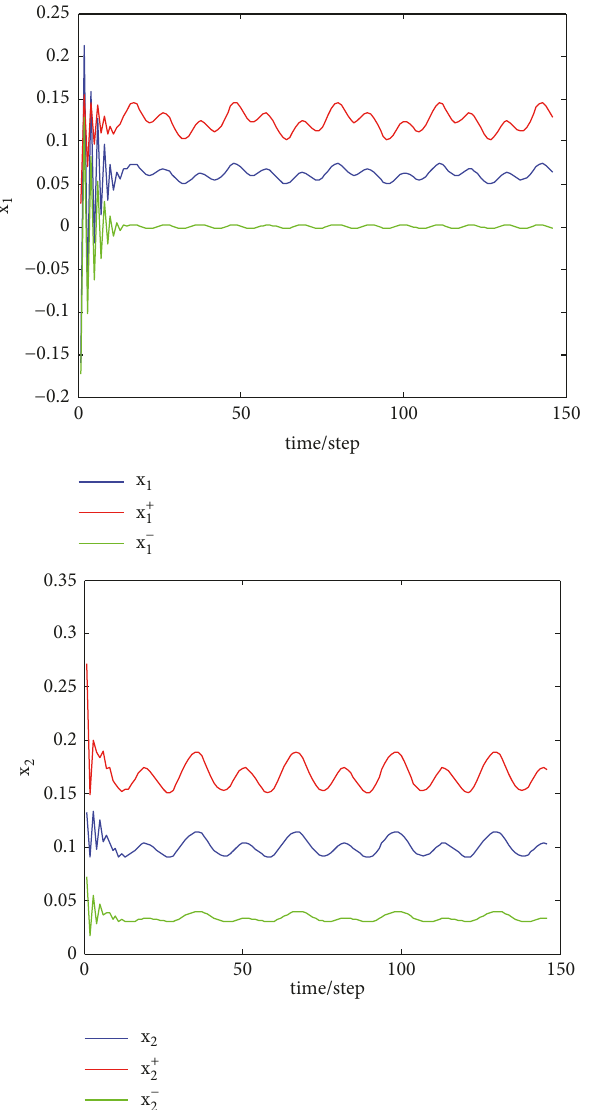
Figure 1: Interval state estimation of linear multicelluar